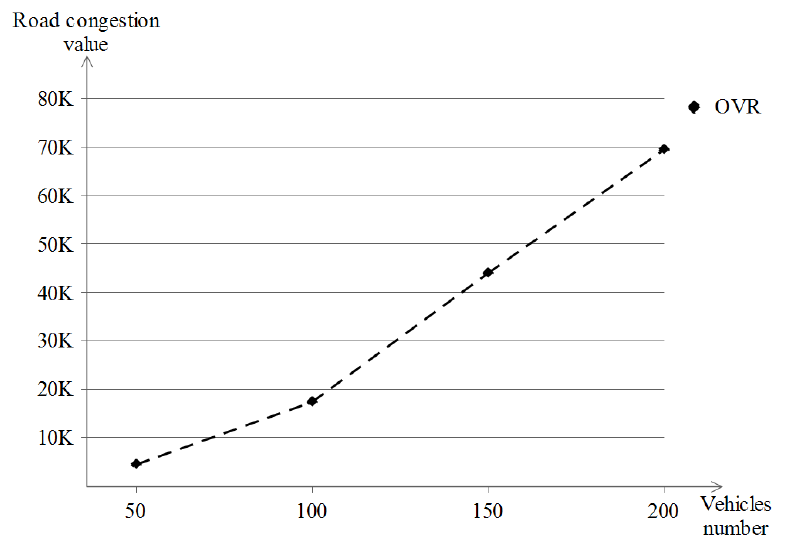
Figure 25. Value of the total road congestion in the Manhattan